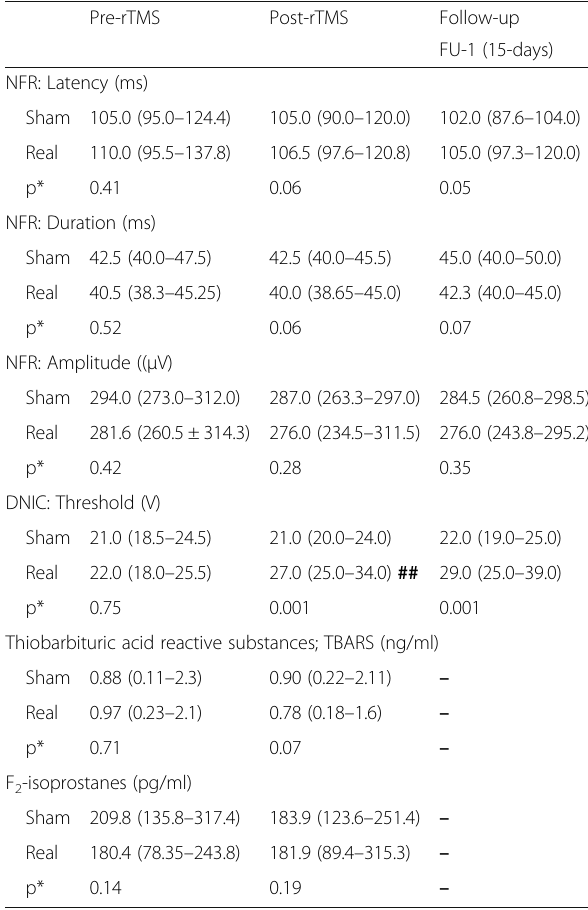
Table 3 Comparison of objective pain measures and oxidative stress markers between FMS Sham-rTMS and Real-rTMS group Pre-rTMS